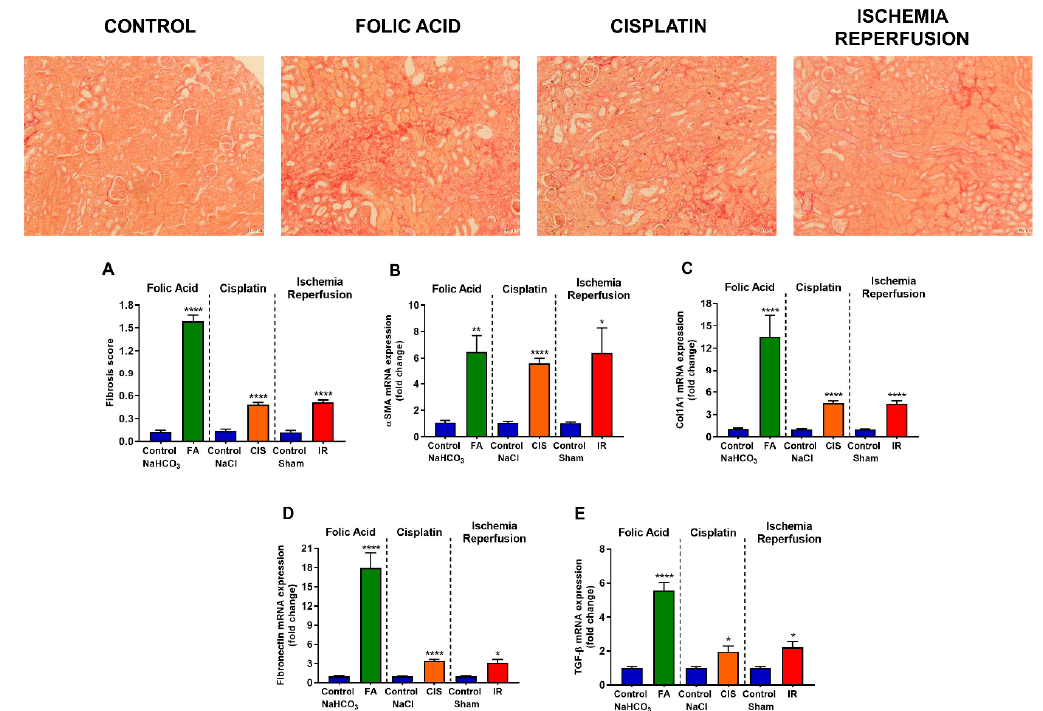
Figure 3. Fibrosis and mRNA levels of fibrotic markers. Representative photomicrography of picrosirius red staining at 10x magnification. Fibrosis score ( A ) and mRNA levels of fibrotic markers in renal tissue ( B – E ) after folic acid (FA) treatment, cisplatin (CIS) treatment, and ischemia reperfusion (IR) surgery. Scale bars = 50 µM. Data presented as mean ± SEM; n = 6–8. Two-tailed Student´s t-test. * p < 0.05; ** p < 0.01; **** p < 0.0001.